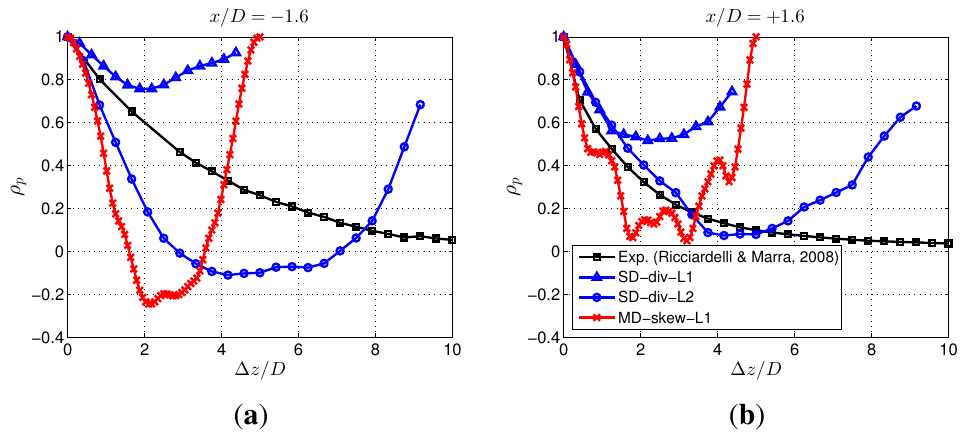
Figure 15. Longitudinal lines considered for the calculation of the correlation of pressures for the rectangular 5:1 cylinder: a spanwise position close to the leading edge ( a ) and one close to the trailing edge ( b ) were chosen.